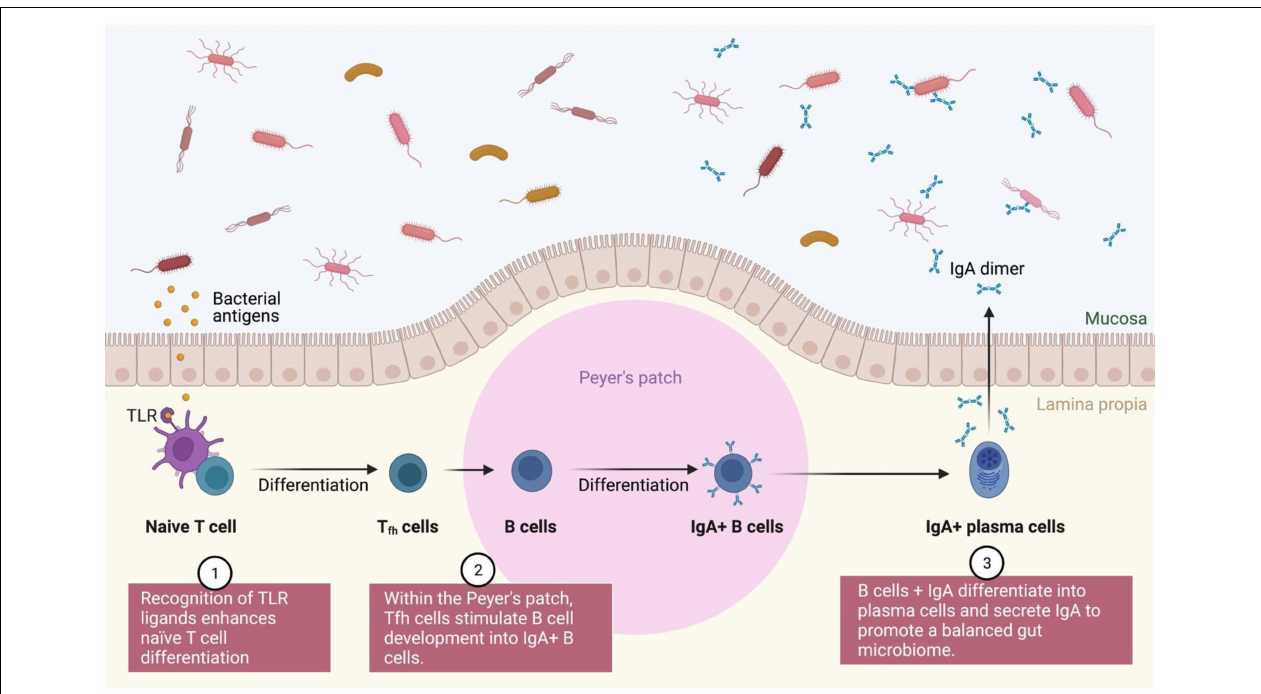
FIGURE 7 | IgA modulated gut microbiota regulation. The interaction between TLR and naïve T cell leads to sequence of differentiation process into plasma cells for modulation of a healthy gut microbiota. TLR, Toll-like receptors; Tfh, T follicular helper; IgA, Immunoglobulin A.